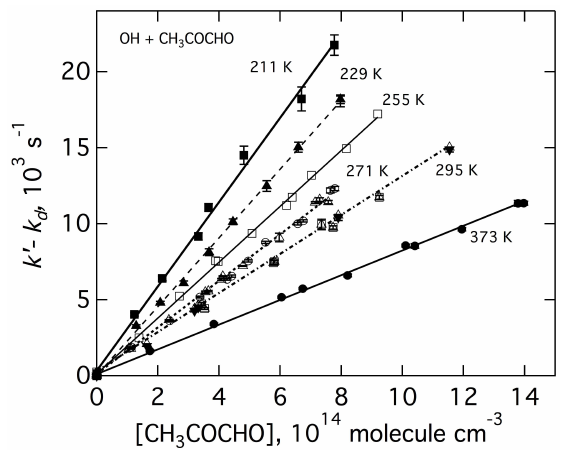
0 ) vs. [CH 3 COCHO] where the data points Fig. 3. Plots of ( k 0 − k d were obtained using 248nm photolysis of H 2 O 2 for the OH radical source in the absence and presence of O 2 . The error bars for indi- 0 vidual k 0 − k values are 2 σ precision obtained from fits as shown d in Fig. 2. The lines are linear least-squares fits to all the data at each